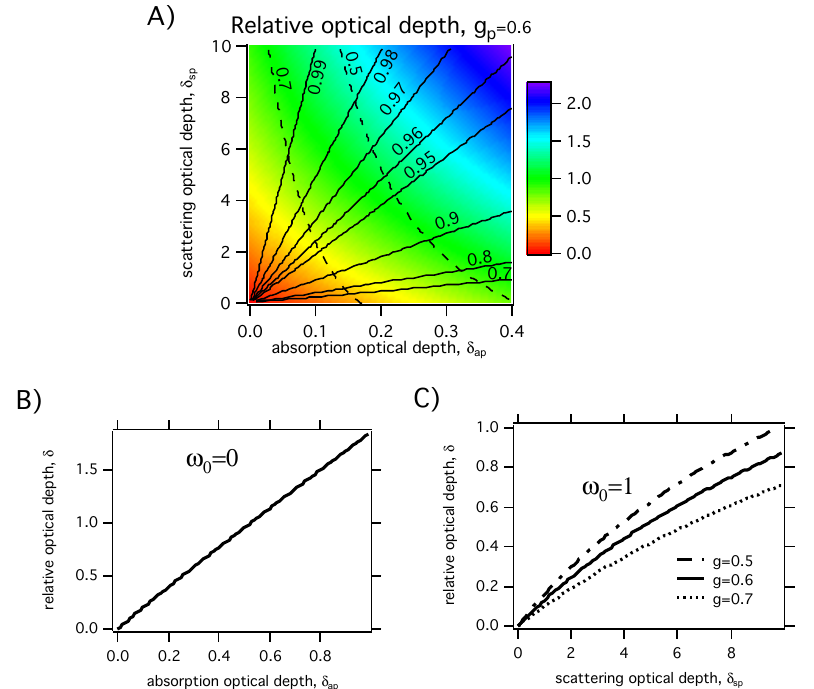
Figure 6. Modeled relative optical depth. (a) Relative optical depth for ranges of particle absorption and scattering optical depths for a particle asymmetry parameter of g p = 0 . 6. The solid lines are isolines for single-scattering albedos and the dashed lines indicate isolines for relative transmittances. (b) Relative optical depth for hypothetical absorbing but not scattering particles. (c) Relative optical depth for loading with non-absorbing particles with particle asymmetry parameters from 0.5 to